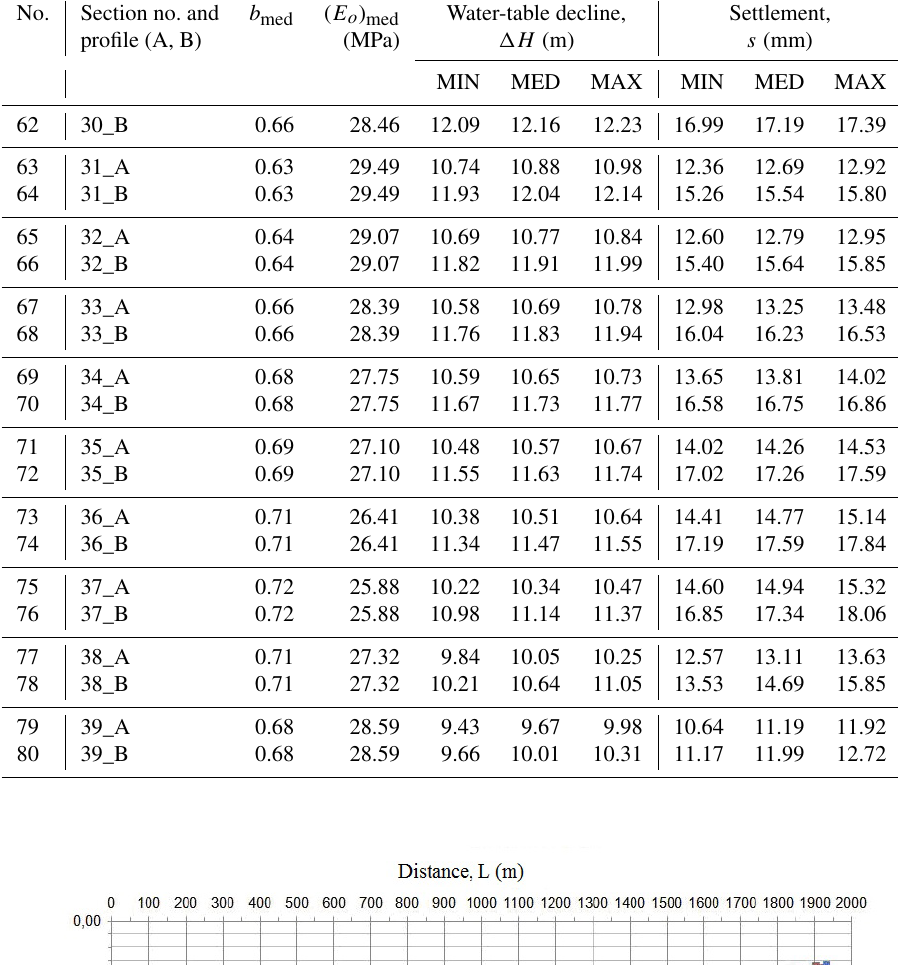
Table 2. Fragment of the table showing the calculated subsidence for AA (cid:48) and BB (cid:48) profiles in the points located in the centers of tunnel sections.